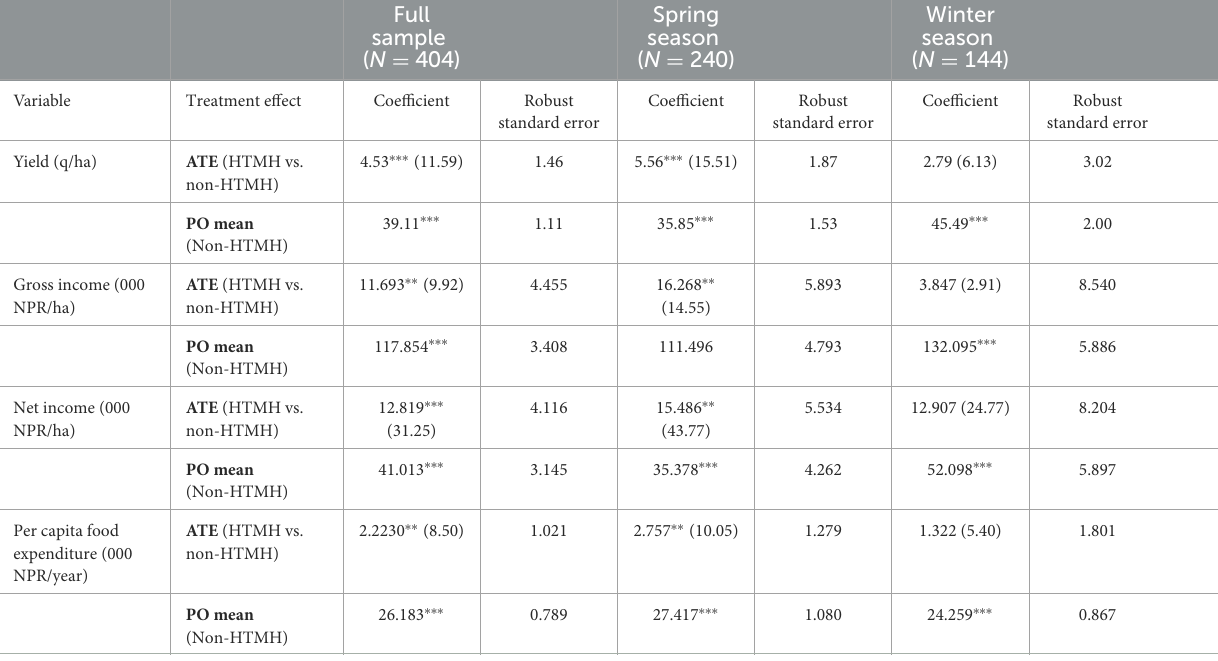
TABLE 7 Treatment effect model: inverse probability weighted regression adjustment